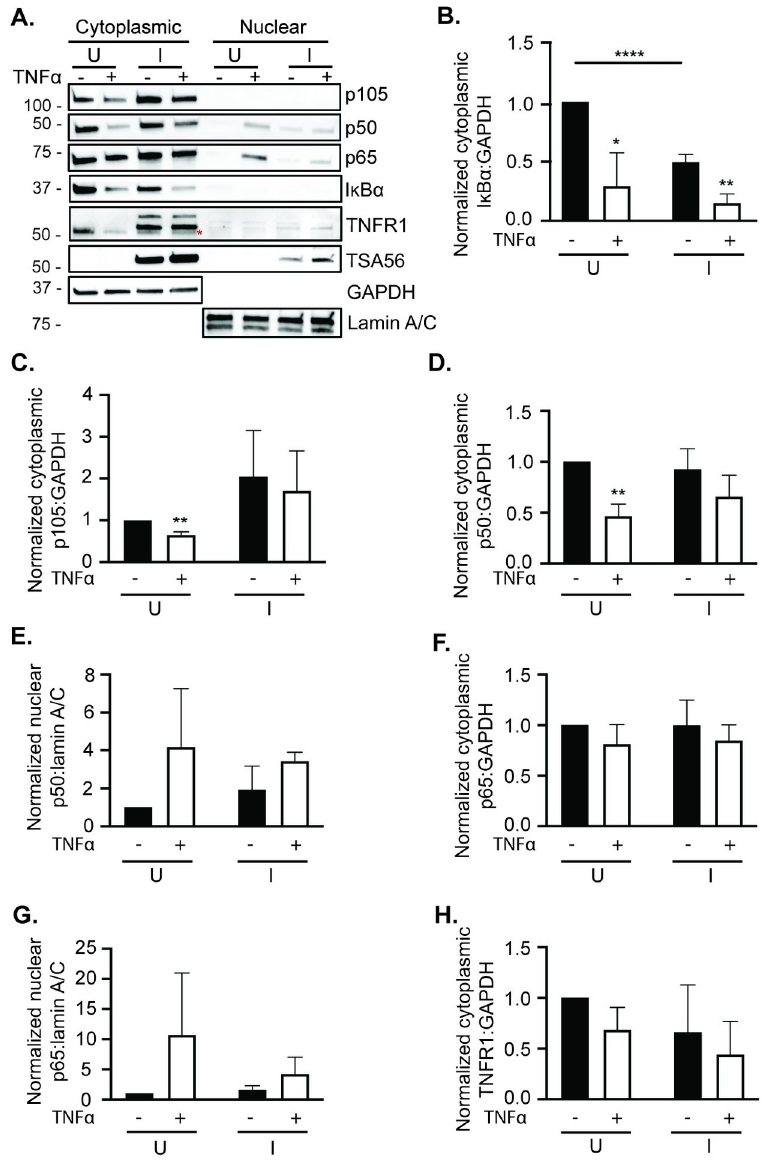
Fig 4. p105 levels remain elevated in O . tsutsugamushi infected cells treated with TNF α . HeLa cells were mock infected (U) or infected with O . tsutsugamushi at a MOI of 10 (I). At 72 h, the cells were treated with TNF α (+) or vehicle control (-). Cytoplasmic and nuclear fractions were analyzed by Western blot with the indicated antibodies (A). (B to G) Mean normalized ratios + SD of cytoplasmic I κ B α :GAPDH (B), cytoplasmic p105:GAPDH (C), cytoplasmic p50:GAPDH (D), nuclear p50:lamin A/C (E), cytoplasmic p65:GAPDH (F), nuclear p65:lamin A/C (G), and TNFR1: GAPDH (H) from three independent experiments were calculated using densitometry. A red asterisk distinguishes the expected size for TNFR1 from the two bands of higher apparent molecular weights exclusively present in lysates of infected cells. Statistically significant ( � , P < 0.05; �� , P < 0.01; ���� , P < 0.0001) values are